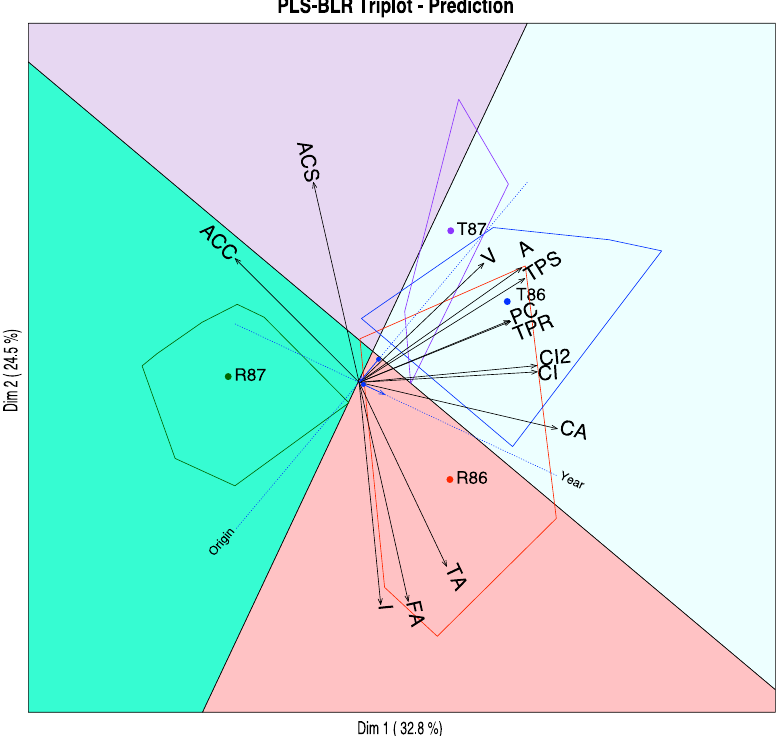
Figure 9. Prediction regions for the combination of both